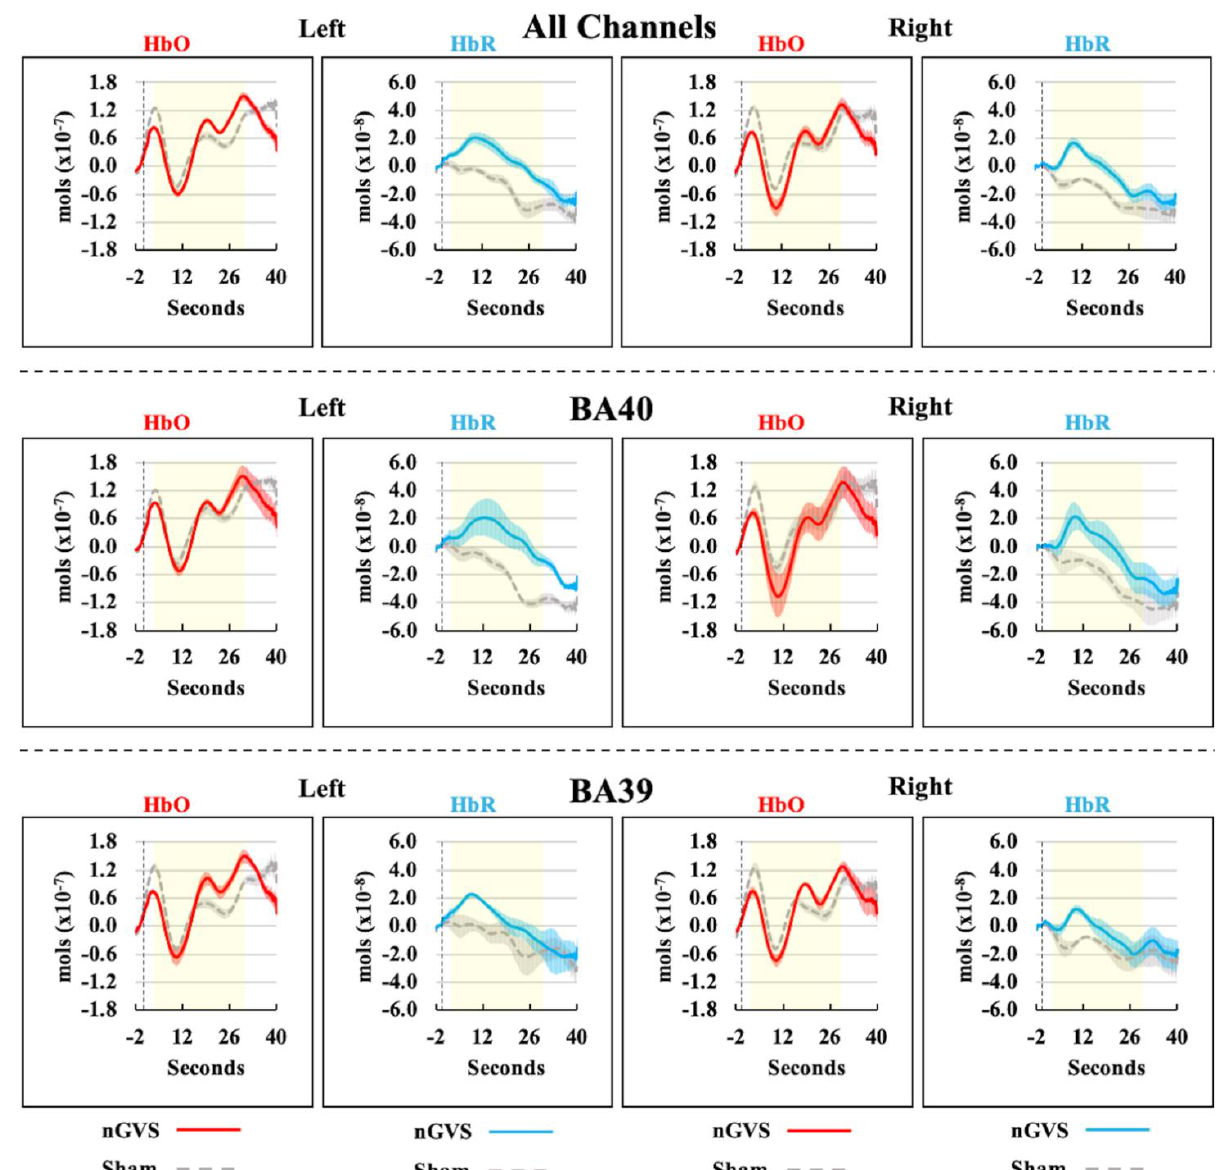
Figure 3. Hemodynamic response function for HbO and HbR for all channels combined ( top panel ), BA40 ( middle panel ), and BA39 ( bottom panel ) in nGVS and sham conditions. Concentration changes (mean: solid line; standard error: shade) of channel combinations vs. time (s) are presented. Columns 1 and 2 correspond to values of the left hemisphere, whereas columns 3 and 4 corresponds to values of the right hemisphere. Vertical dashed lines indicate the onset of nGVS (i.e., time 0). Participants received stimulation from 0 to 30 s. Yellow rectangle indicates analysis window (i.e., 3 to 30 s after stimulation onset).